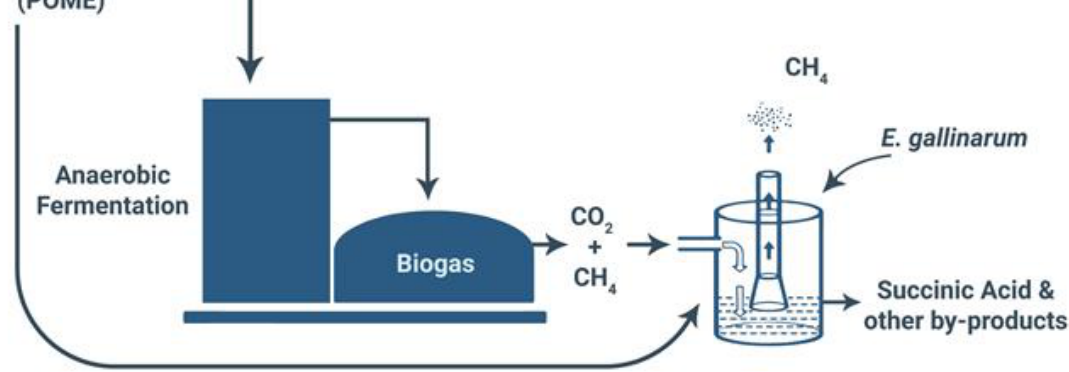
Figure 1. The proposed idea containing succinic acid and biogas purification for the sustainability of the palm oil mill